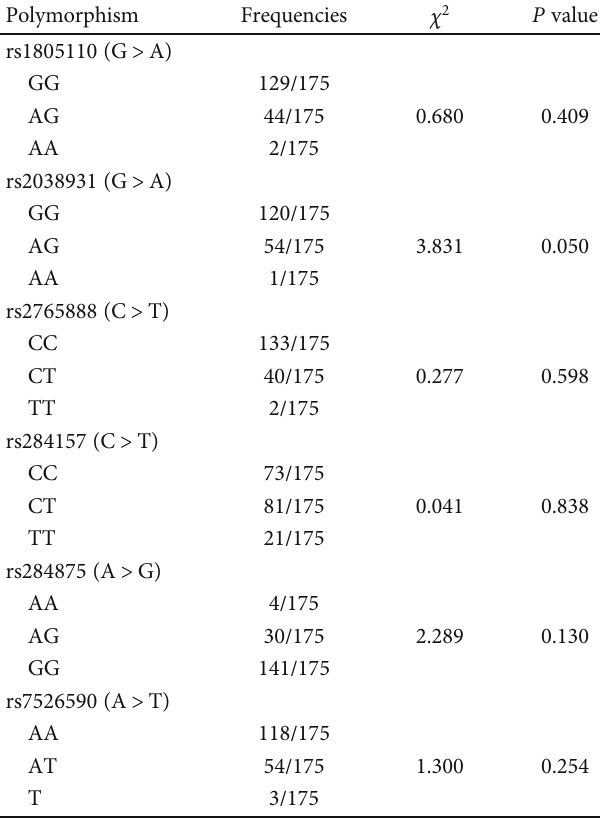
Table 1: Hardy-Weinberg equilibrium values for each TGFBR3